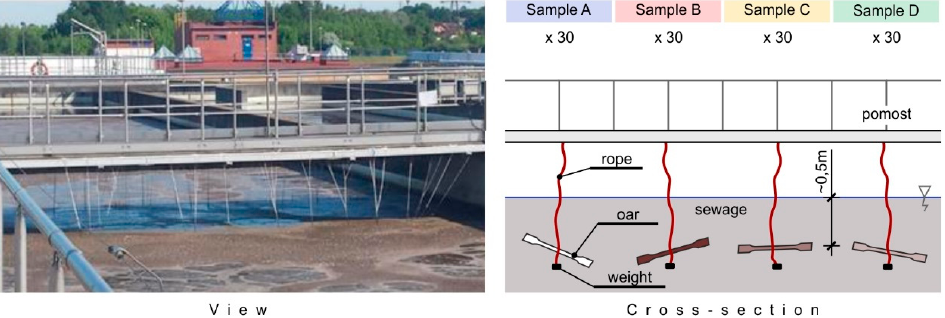
Figure 2. Samples suspended in the bioreactor (in the nitrification chamber).